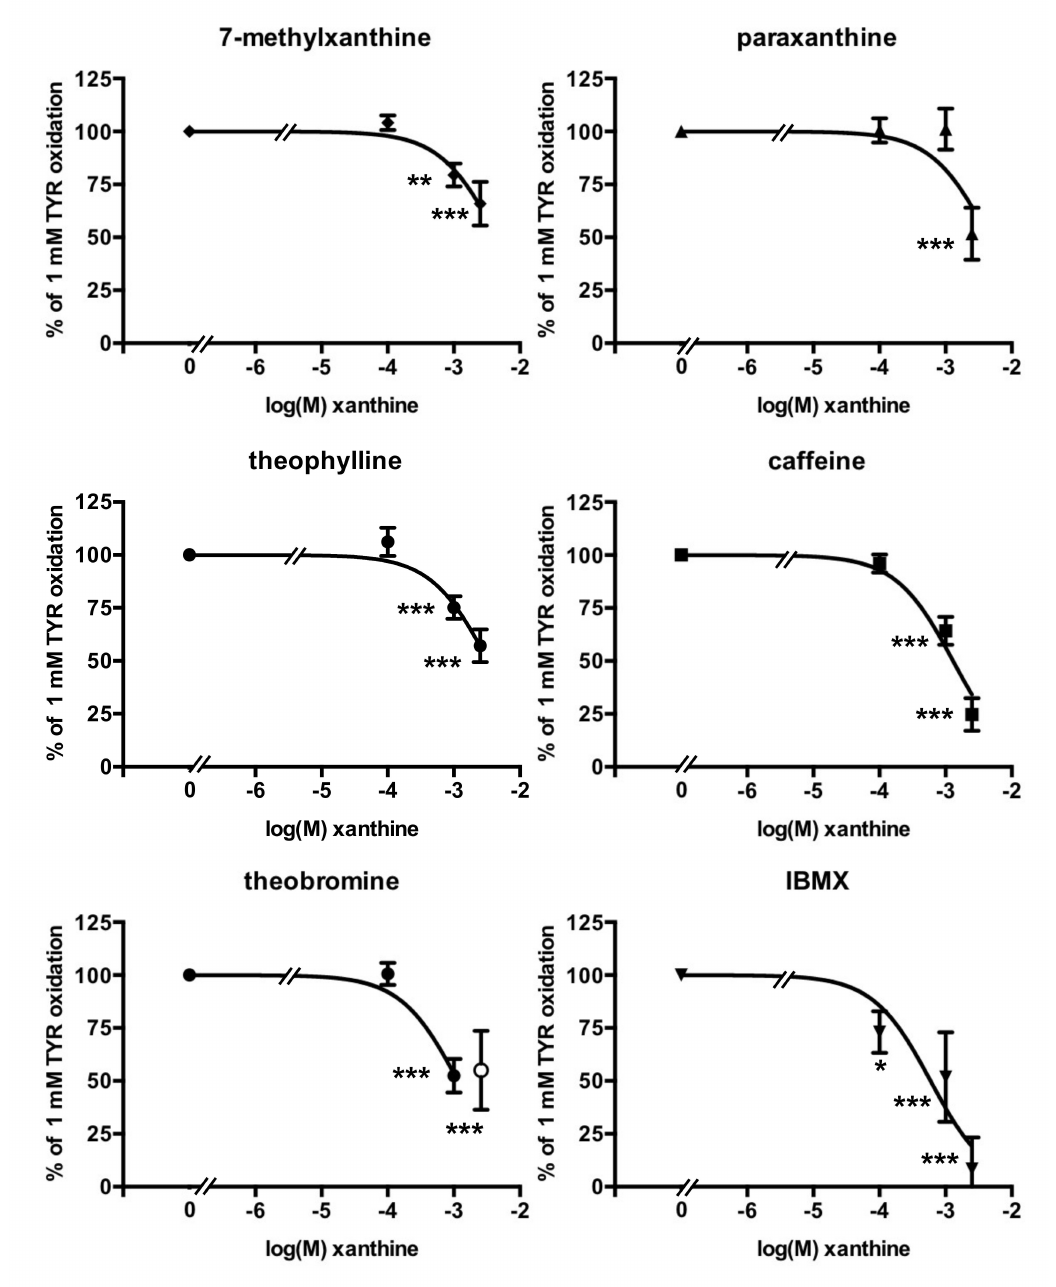
Figure 6. Dose-dependent inhibition of tyramine oxidation by methylxanthines. The control consisted of a standard assay of MAO-dependent oxidation of 1.0 mM tyramine (TYR) by hScAT homogenates, performed in triplicate for each of the 25 individuals and set at 100%. Mean ± SEM of the number of observations indicated for each agent: 7-methylxanthine: 14–16; Paraxanthine: 8; Theophylline: 20; Ca ff eine: 8–18; Theobromine: 8–19; IBMX: 7. For theobromine, the (open) symbol at 2.5 mM is di ff erent from those of lower doses to denote the extensive influence of 25% v / v DMSO vehicle needed for this xanthine at this dose, which could not be accurately estimated. The di ff erence from control (plotted as 0 on the X-axis) at: * p < 0.05; ** p < 0.01; *** p < 0.001 was determined by one-way